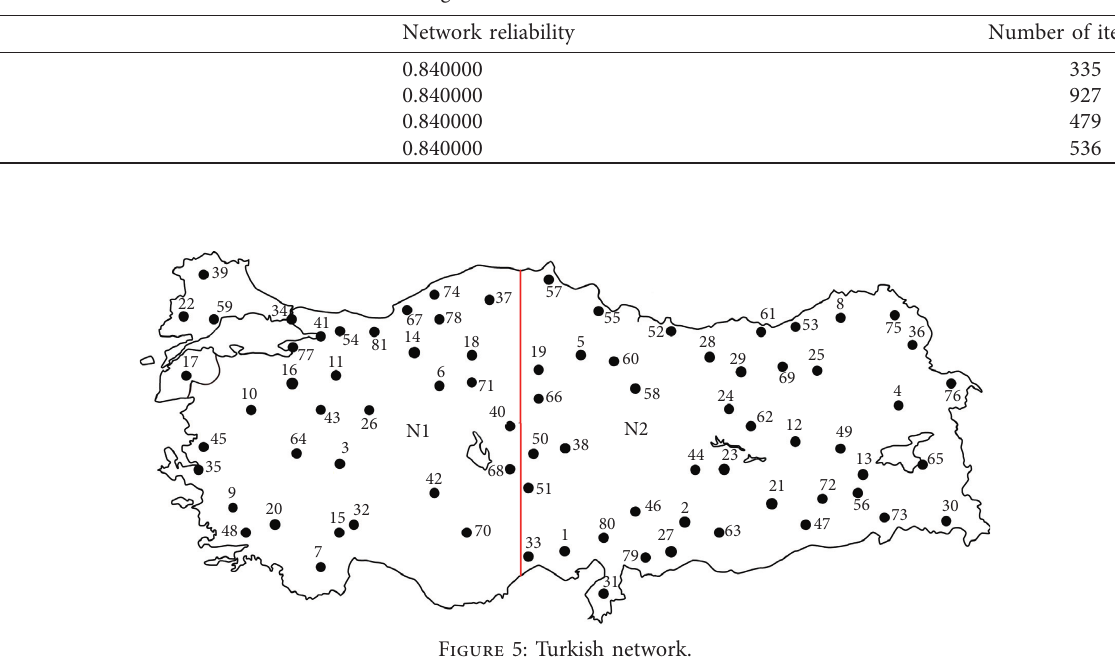
Table 3: The convergence of TS with different sizes of the tabu